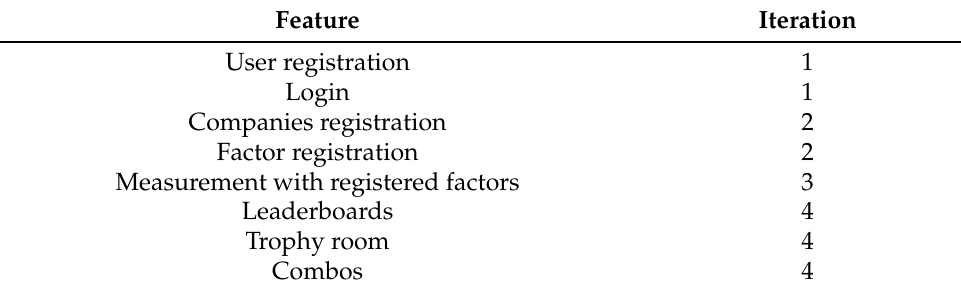
Figure 3. Platform architecture. Table 1. Features and